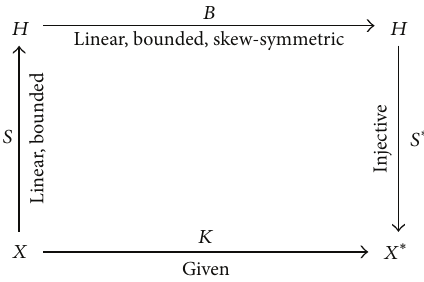
Figure 1: Factorization of operator, 𝐾